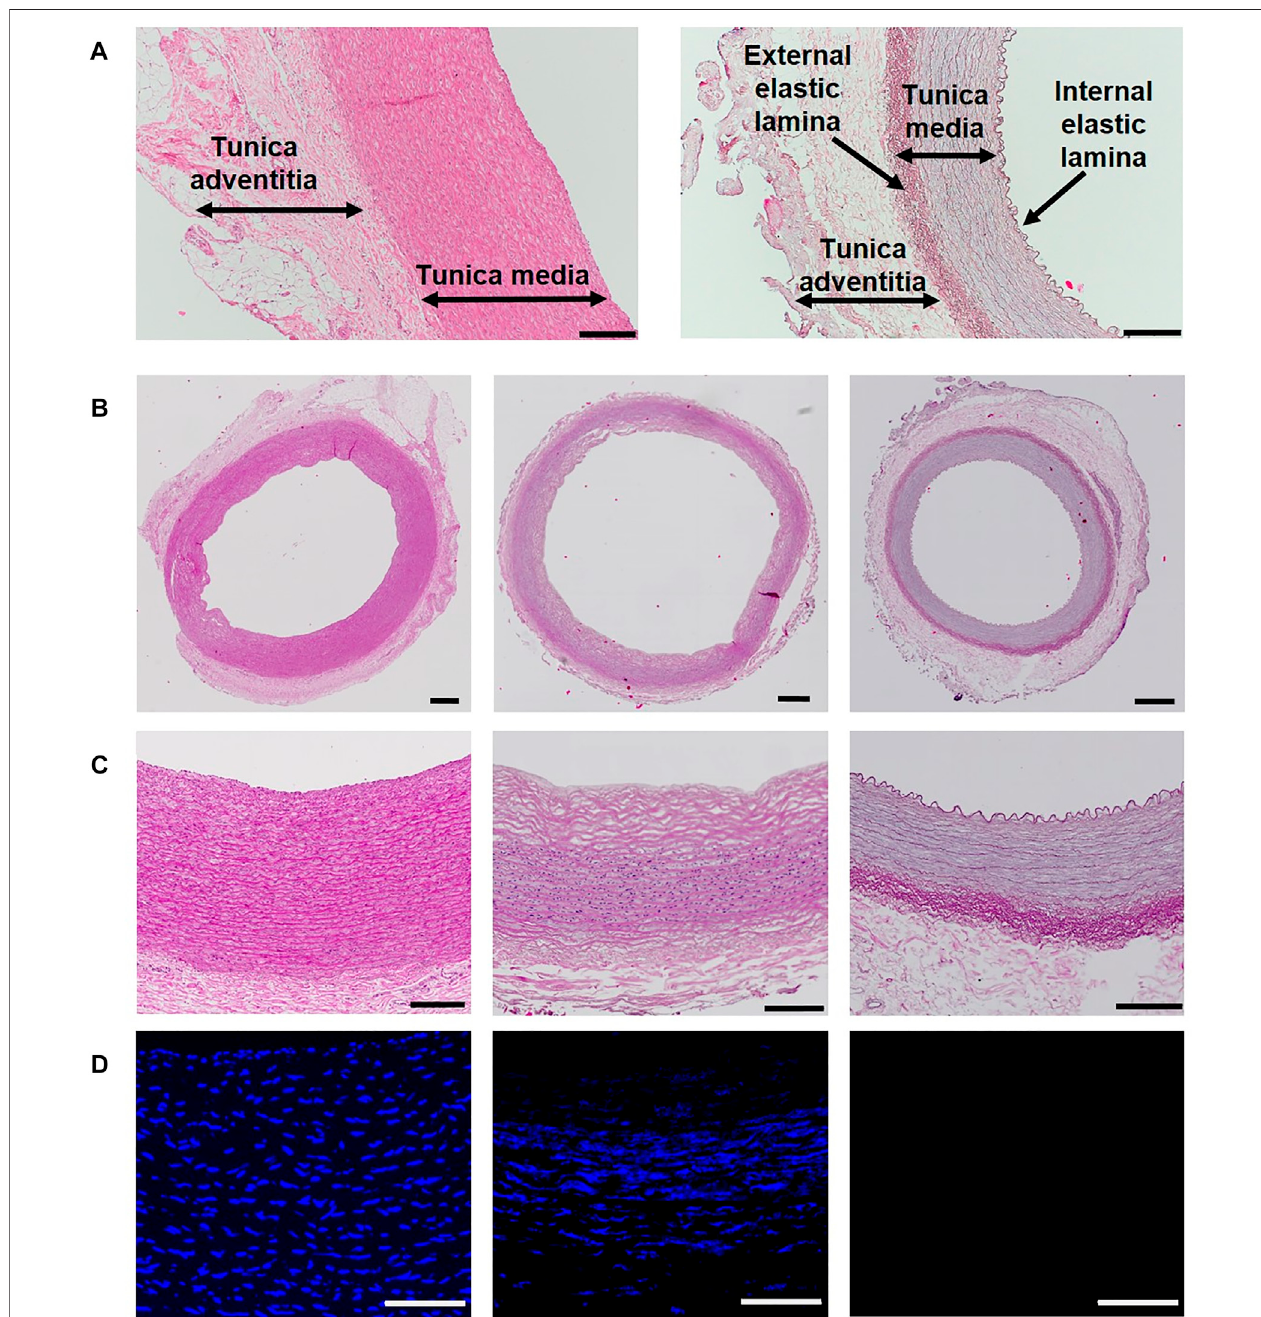
FIGURE2| Porcinecoronaryarterylayersandevaluationofthedecellularizationef fi cacy: (A) detailedimageofthenative(left)anddecellularized(right)carotidartery wall with the identi fi cation of the wall layers. It is evident that in the native vessel, the internal and external elastic laminas between each layer are indistinguishable, while theycanbeeasilyidenti fi edinthedecellularizedscaffold.Thescalebaris200 μ m. (B) H&Estainingoftheentiresection(nativeontheleft,partiallydecellularized(score2) inthemiddleandcompletelydecellularizedscaffoldontheright) – scalebaris500 μ m; (C) detailsofthevesselwallfrompicturesin (B) tovisualizethenucleistained withhematoxylin – scale bar is 200 μ m; (D) DAPI immuno fl uorescence at magni fi cation ×40showingnuclear loss in the middle picture and complete cell removal on the right side) scale bar is 100 μ m.